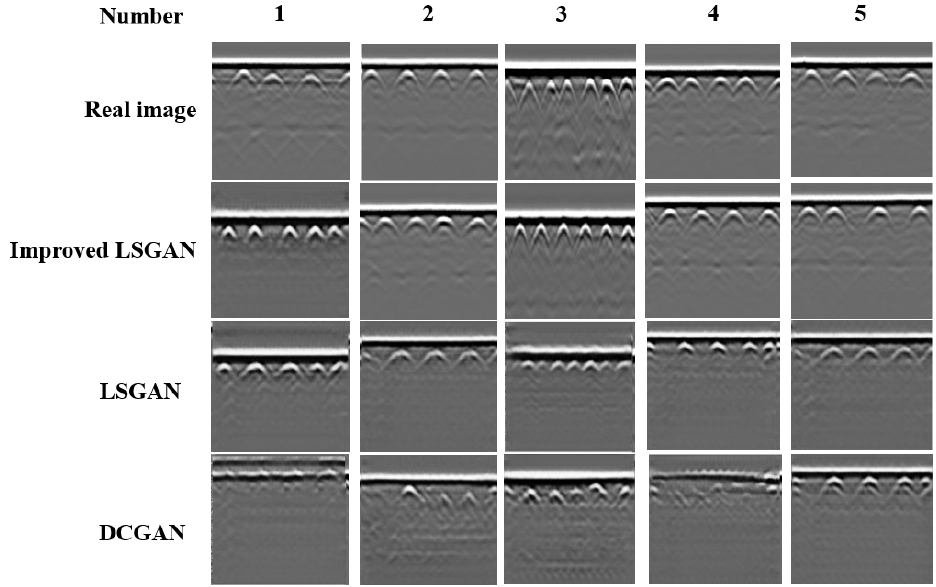
Figure 6. GPR images generated by LSGAN, DCGAN and improved LSGAN using field images. The calculated FID score by using PyTorch shows that the improved LSGAN model achieves a FID score of 29.6 (lower scores correspond to better GAN performance). The FID score of DCGAN and LSGAN are, respectively, 67.5 and 47.6, which are much higher than results by the improved LSGAN. It means that the improved LSGAN can extract more rebar features than the DCGAN and LSGAN from field GPR images. More im ‐ portantly, the images generated by the improved LSGAN contain more rebar targets than the field GPR images, which improves the diversity of training dataset.